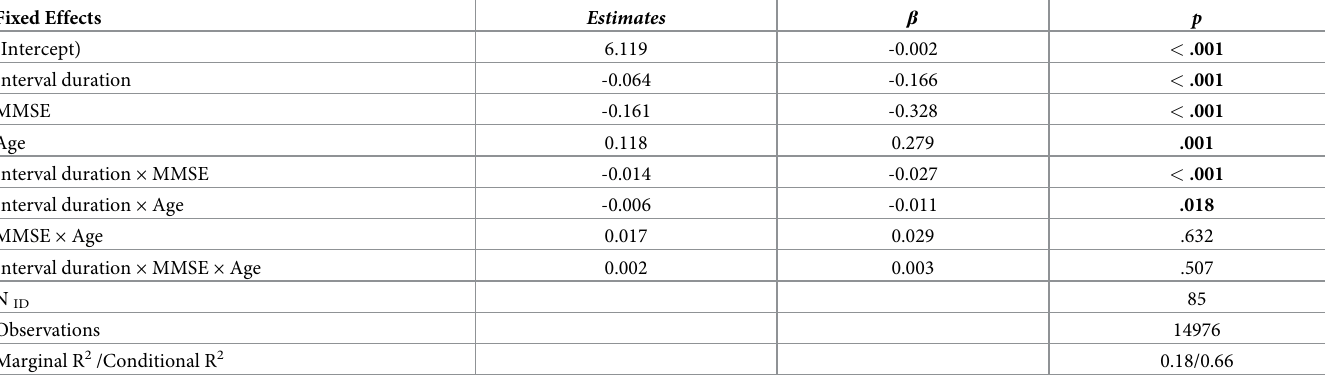
Table 3. Summary of the model outputs for the implicit timing